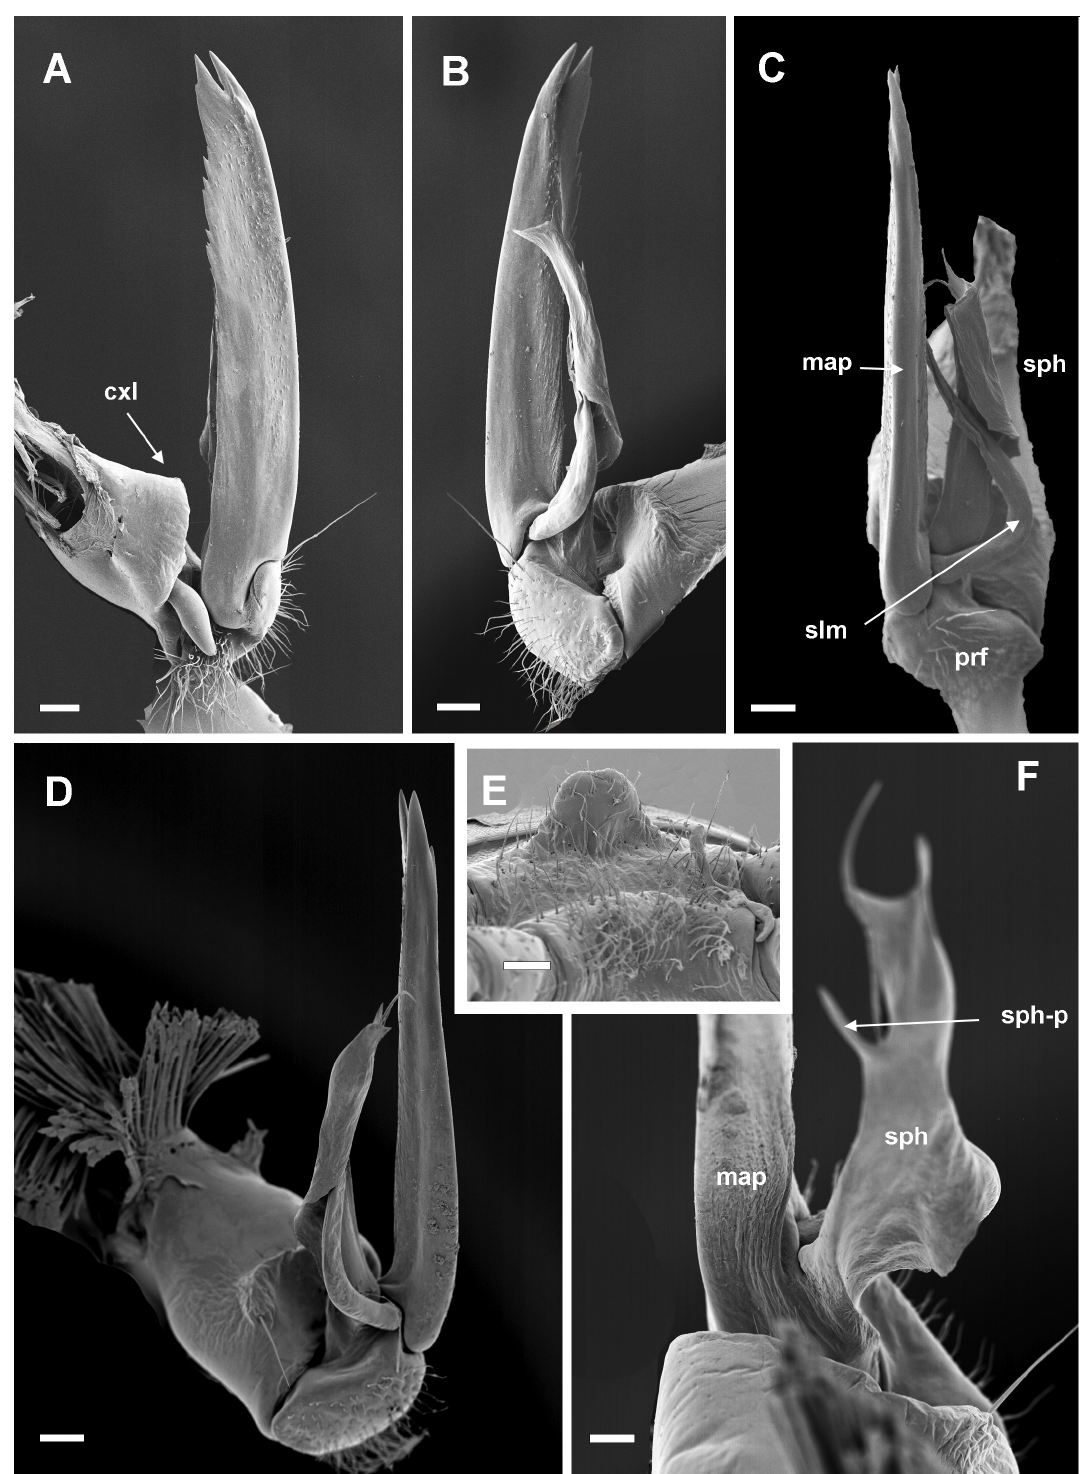
Fig. 22. Eviulisoma dabagaense Kraus, 1958. A–C . Topotype, ♂, left gonopod. A. Mesal view. B. Lateral view. C. Ventral view. D–F . ♂ from Udzungwa Scarp FR, above Chita Village, right gonopod. D. Ventrolateral view. E. Sternal lobe between legs 4. F. Subdorsal view, emphasizing solenophore. Abbreviations: cxl = coxal lobe; map = mesal acropodital process; prf = prefemur; slm = solenomere; sph = solenophore; sph-p = slender process from sph. Scale bars: A–E: 0.1 mm; F = 0.05